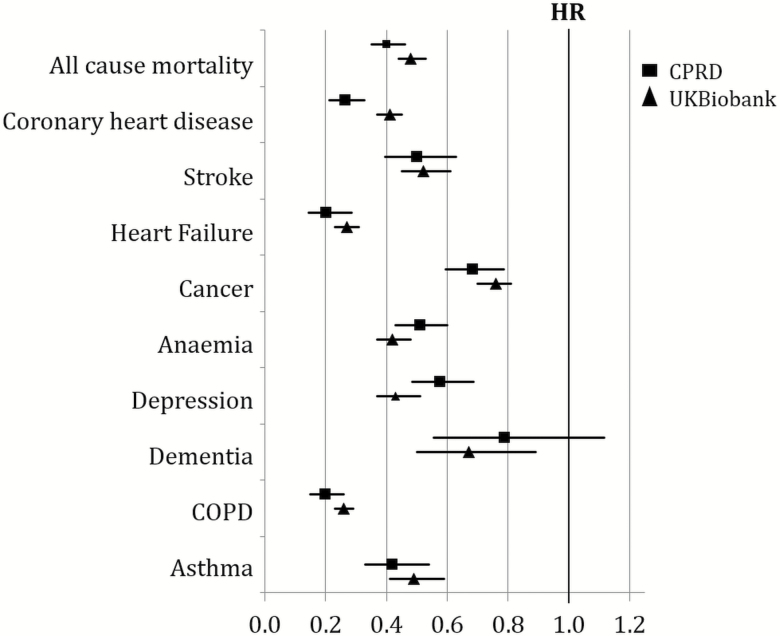
Hazard ratios (95% confidence intervals) for mortality and subhazard ratios (competing risk models) for incident conditions for individuals in the low cardiovascular disease risk score (CRS) (high CRS as reference), during ≤10 years of follow-up. Clinical Practice Research Datalink (CPRD) (n = 239,591): Adjusted for age, sex, index of multiple deprivation, and year of admission into the study. UK Biobank (n = 181,820): Adjusted for age, sex, ethnicity, education, and socioeconomic deprivation index (Townsend deprivation index). Participants with prevalent disease at baseline were excluded. Cancer excludes non-melanoma skin cancer.